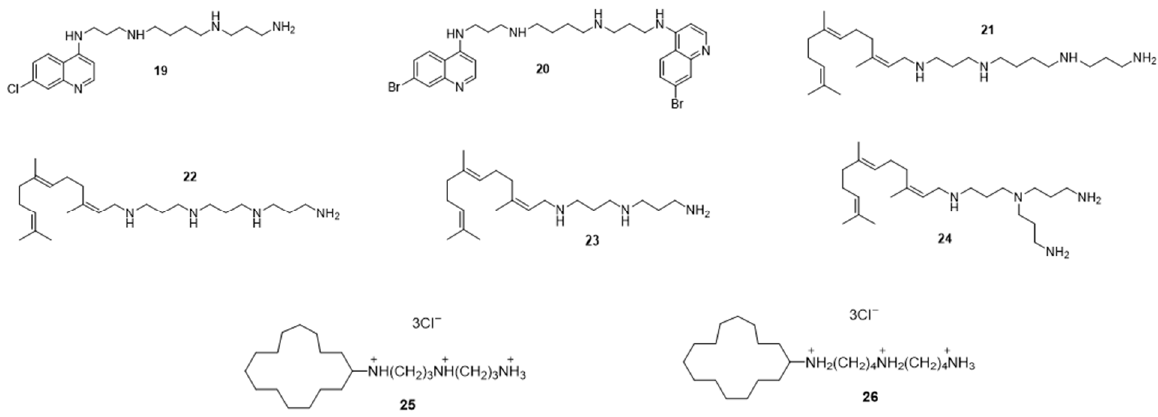
Figure 8 . Polyamine derivatives 19 - 26 . Figure 8. Polyamine derivatives 19–26